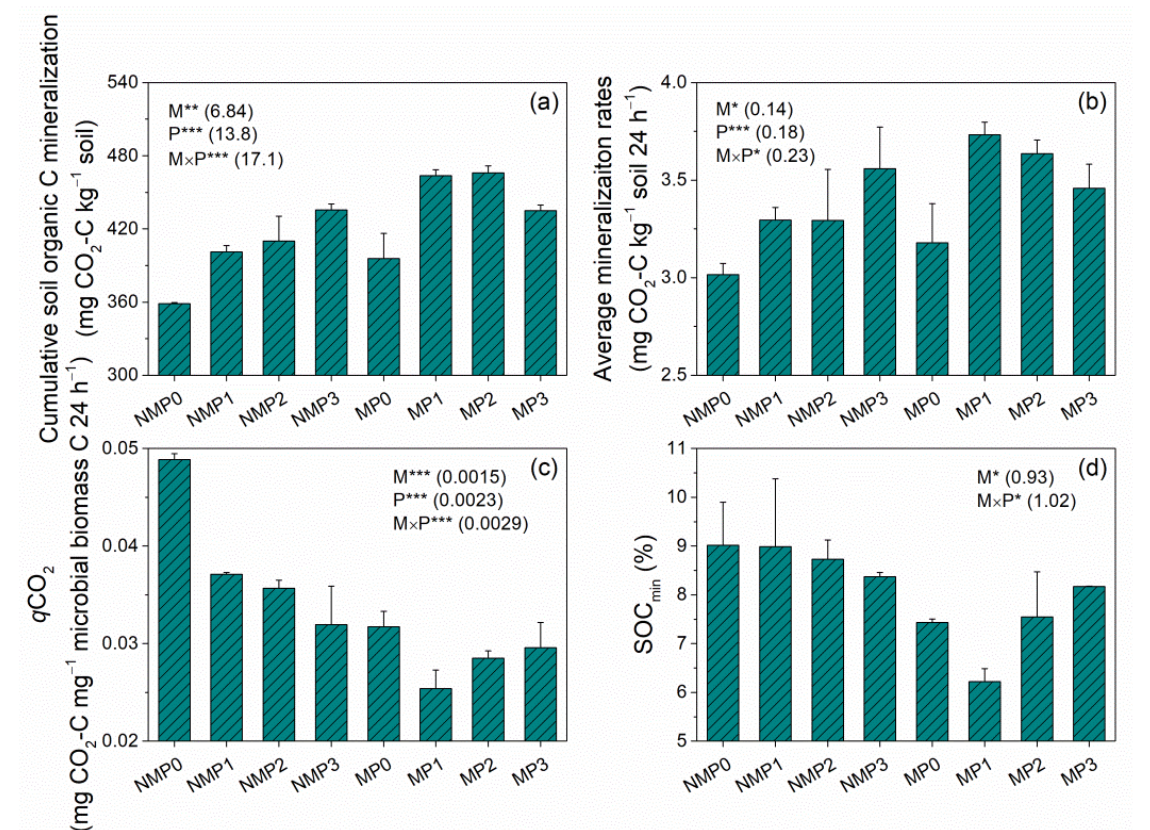
Figure 4. Cumulative soil organic C (SOC) mineralization over 175 days (C m , a ), average mineralization rates ( b ), q CO 2 (metabolic quotient, average cumulative SOC mineralization over 175 days per unit microbial biomass carbon in July 2015, c ), and SOC min (SOC mineralization intensity, cumulative SOC mineralization over 175 days per unit of initial SOC in July 2015, d ) under no film mulching (NM) and film mulching (M) at four P levels (P0, P1, P2, and P3). * p ≤ 0.05, ** p ≤ 0.01, and *** p ≤ 0.001. Numbers in brackets are LSD at p = 0.05. Error bars are standard deviations.